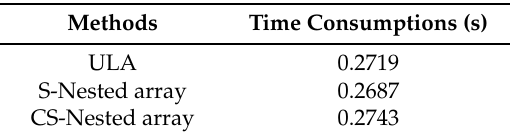
Table 3. The time required for estimating the DOAs of three